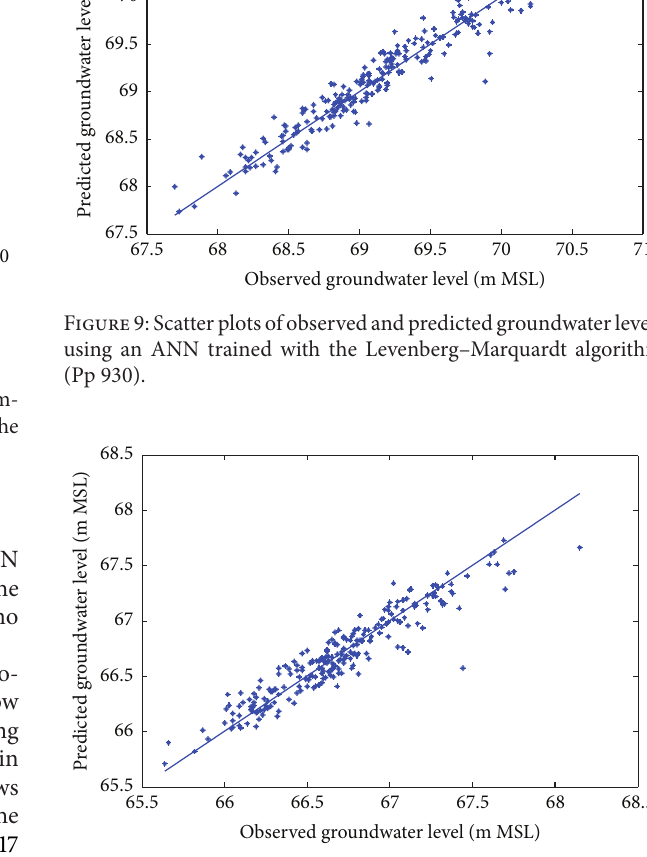
Figure 10: Scatter plots of observed and predicted groundwater lev- els using an ANN trained with the Levenberg–Marquardt algorithm (Lp